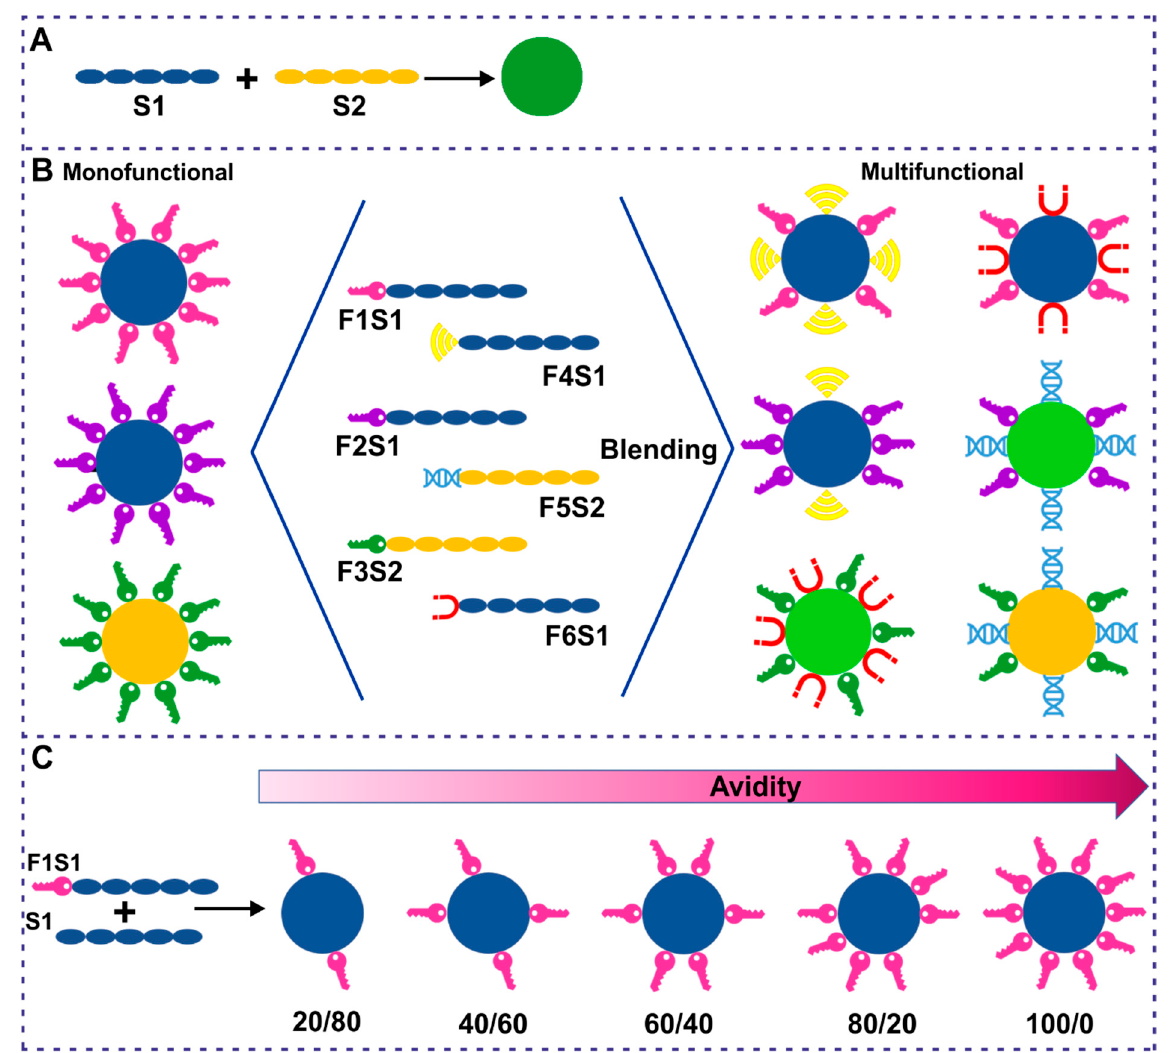
Figure 4. Blending strategy for development of a versatile silk-based drug delivery system. Silk proteins are blended depending on demand before the material (e.g., spheres) formation. ( A ). Blending two types of silk (S1 and S2) to obtain spheres of distinct properties. ( B ). Blending silk proteins of two (or more) distinct functionalization to obtain multifunctional material. ( C ). Blending silk proteins at various ratios to control material’s avidity to cells, drugs, and others molecules.